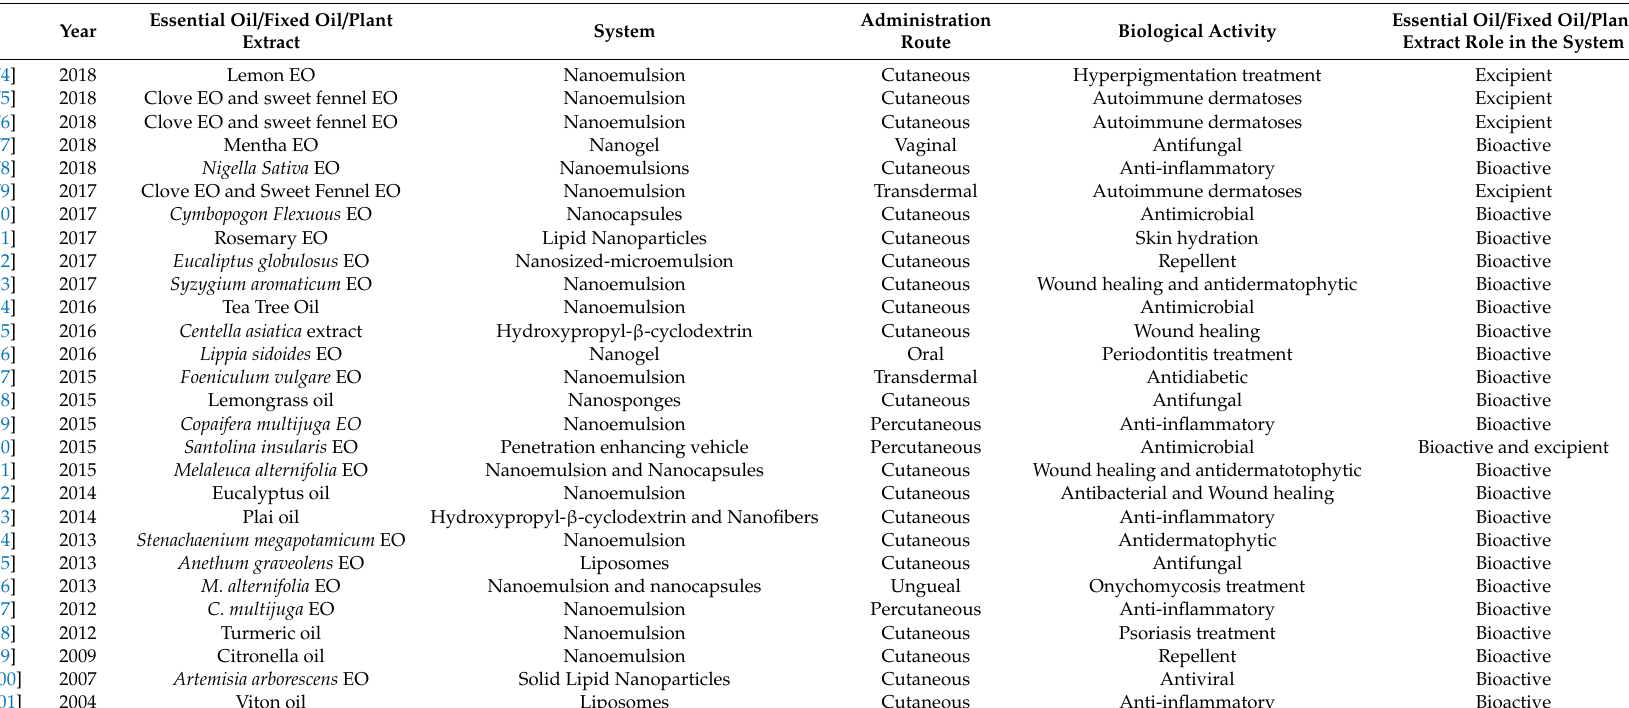
Table 2. Publications found in the literature concerning the encapsulation of essential oils, fixed oils, and plant extract containing terpenes in nanostructured systems intended for topical